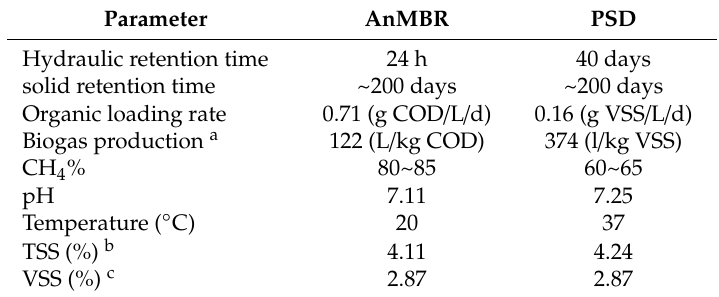
Table 1. Anaerobic membrane bioreactor (AnMBR) and sludge anaerobic reactor (PSD) system operating